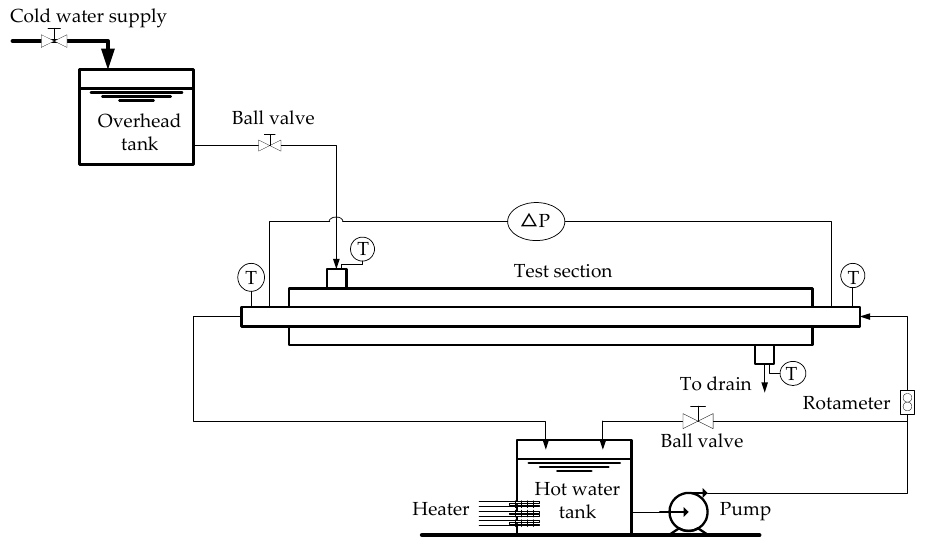
Figure 1. Schematic diagram of the enhanced heat-transfer setup.